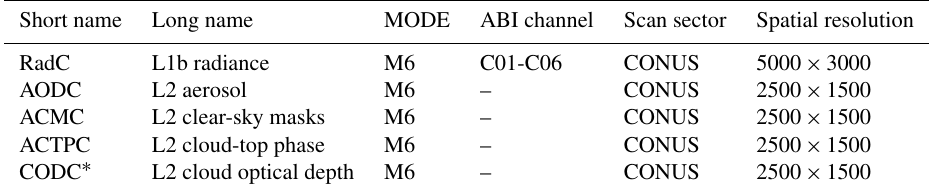
Figure 8. Locations of the six ABI channel SRFs. The x axis is the wavenumber. The y axis is solar irradiance. Table 6. Details on data used as input for